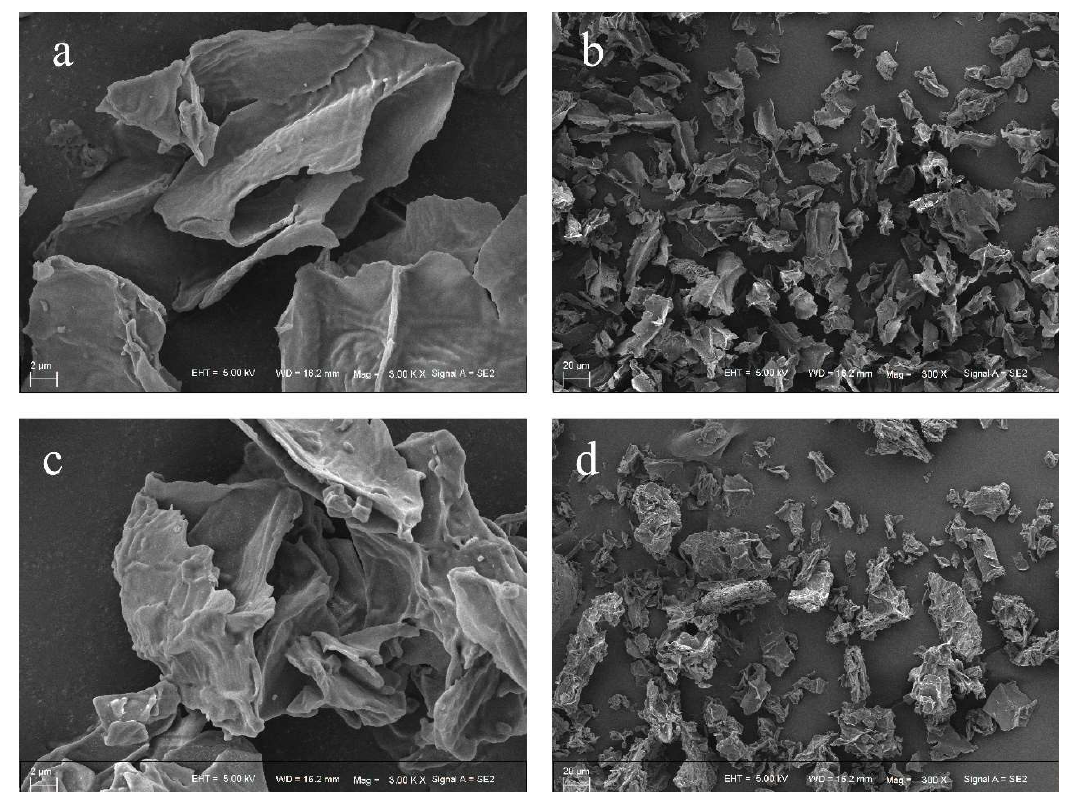
Figure 2. Scanning electron micrograph (SEM) of HPIDF/F-HPIDF. ( a : HPIDF at high magnification; b : HPIDF at low magnification; c : F-HPIDF at high magnification; d : F-HPIDF at low magnification).